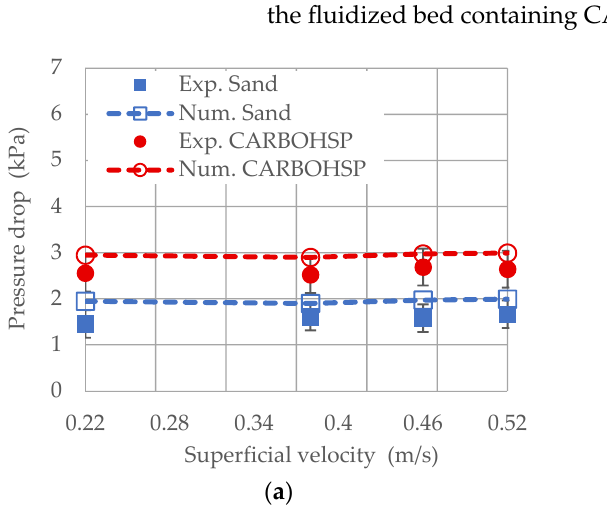
( b ) Figure 3. ( a ) Mesh setting for the computational domain; ( b ) representation of static bed. The origi- nal solid volume percentage of 0.6 is shown in red, while the freeboard is represented in blue. 4. Results and Discussion The main goal of this study is to validate our numerical model from the hydrody- namics and thermal perspectives utilizing data from experimental assessments. Next, the verified model will be used to evaluate the performance of the bed at extremely high tem- peratures. As a consequence, in this section, the results from both experiments and simu- lations are presented and, in certain cases, are compared with each other to validate the numerical model and verify the simulation results. 4.1. Hydrodynamics Results Significant metrics in hydrodynamic result verification include pressure drop, void- age profiles, bed height variation, granular particle velocity distribution, and the shape of the bubbles. Pressure drops and expansion ratios are dealt with in this work based on their appropriate computational properties [12]. The change in pressure drop in a partic- ular portion of the FB is a typical measure in the hydrodynamic domain. In principle, as velocity increases, the pressure drop increases linearly until it reaches a minimum fluidi-